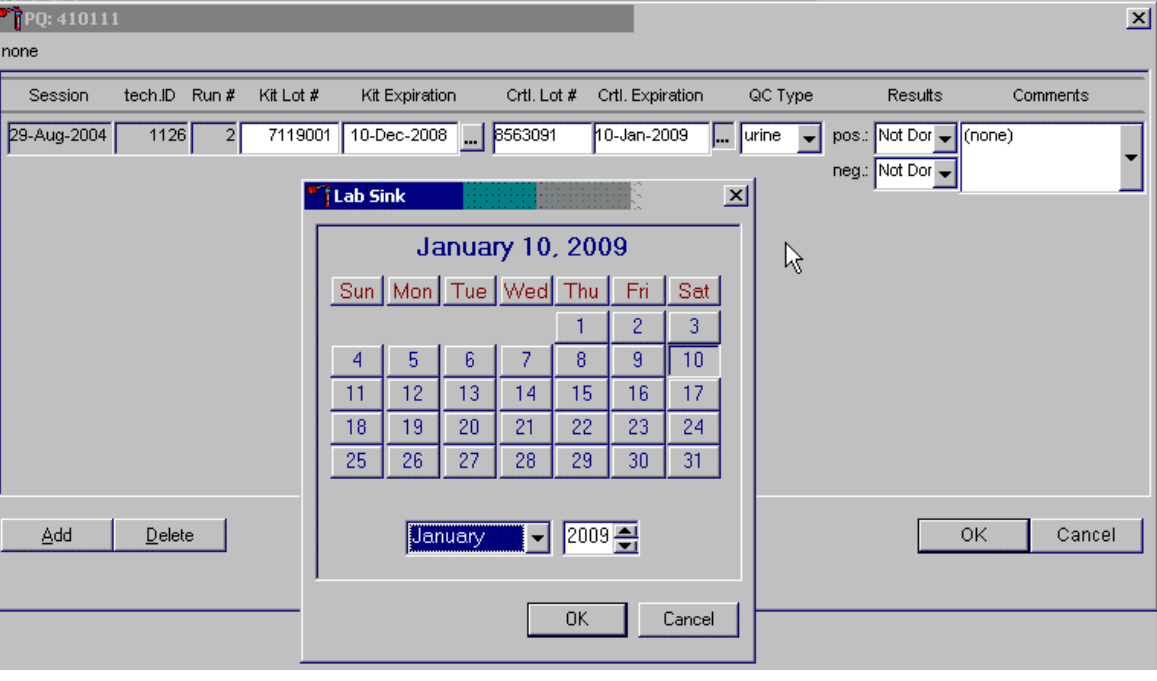
[Tab] or use the calendar to enter the date. To access the calendar, use the mouse to direct the mouse arrow to the ellipsis and left click. To select the correct month, use the mouse to direct the mouse arrow to the drop-down list, drag the arrow to the correct month (use the scroll bar if necessary) and left click. To select the correct day, use the mouse to direct the mouse arrow to the correct day on the displayed month and left click. To correct the year, use the mouse to direct the mouse arrow to up/down controls on the spin box and toggle the year up and down. To transfer this date into the text box, use the mouse to direct the mouse arrow to the OK button and left click; to exit the calendar function, use the mouse to direct the mouse arrow to the Cancel button and left